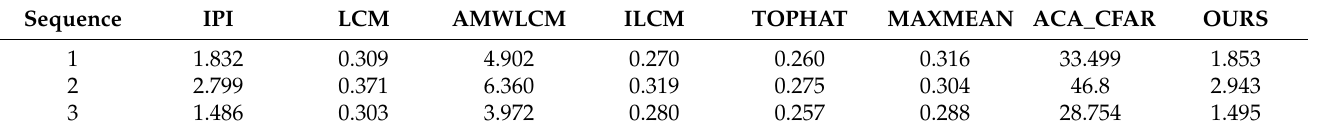
Table 5. Computational cost comparison among the proposed algorithm and other algorithms. (unit: